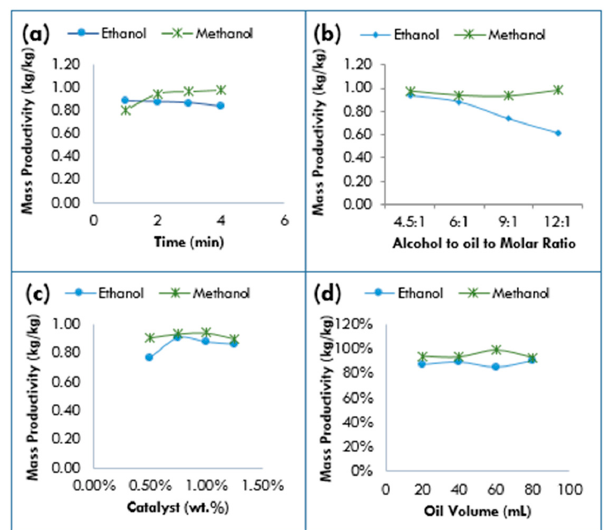
Figure 5. Mass Productivity for the simultaneous effect of MW/US in WCO transesterification. Effect of ( a ) different reaction time; ( b ) alcohol to oil molar ratio; ( c ) catalyst concentration and ( d ) sample (oil) volume.